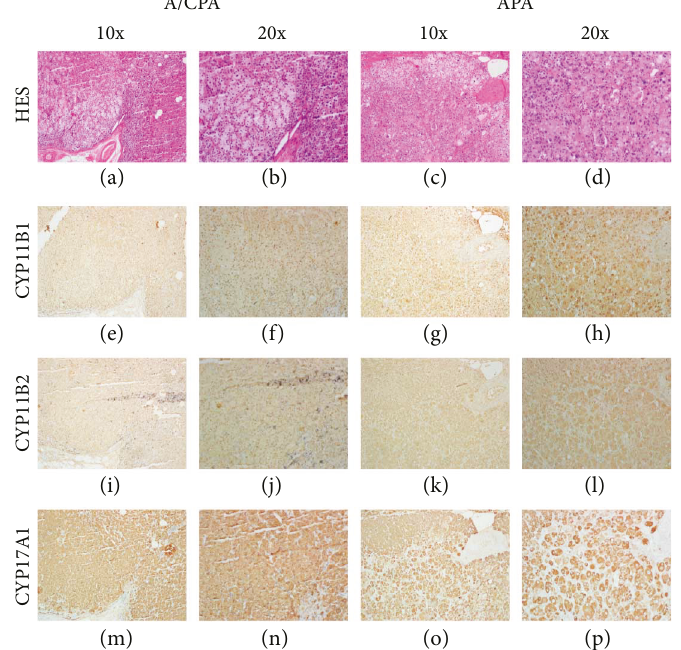
Figure 2: Immunohistochemistry results for CYP11B1, CYP11B2, CYP17A1, and hematoxylin-eosin stain (HES) in A/CPA and pure APA